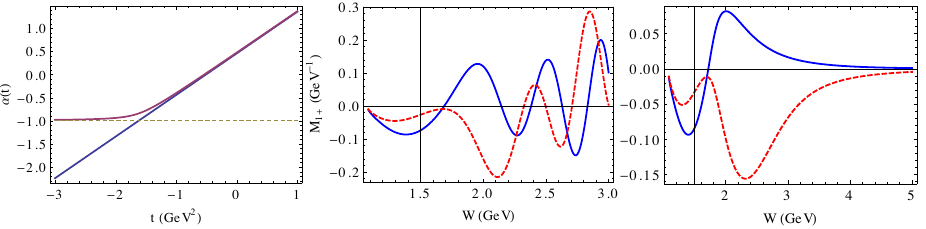
Figure 2. Left panel: linear and saturated Regge trajectory. Middle panel: M 1 + multipole obtained from a Regge amplitude with a linear trajectory. Right panel: same for a saturated trajectory. Solid curves show the imaginary part, dashed curves show the real